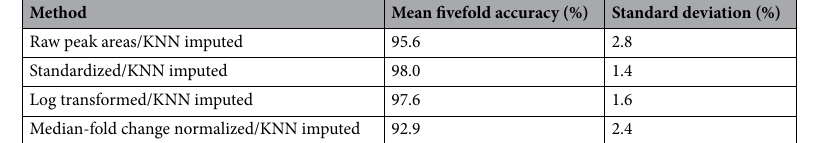
Table 1. Fivefold LCMS accuracy and standard deviation scores for several transformation and imputation schemes post feature